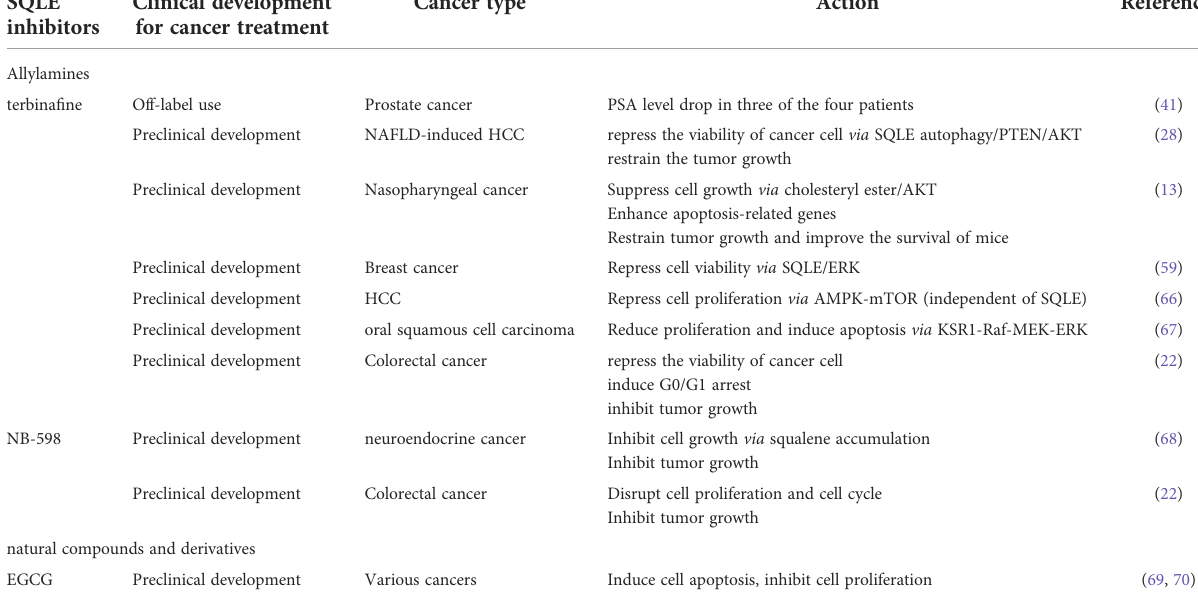
TABLE 2 SQLE-targeted therapies in